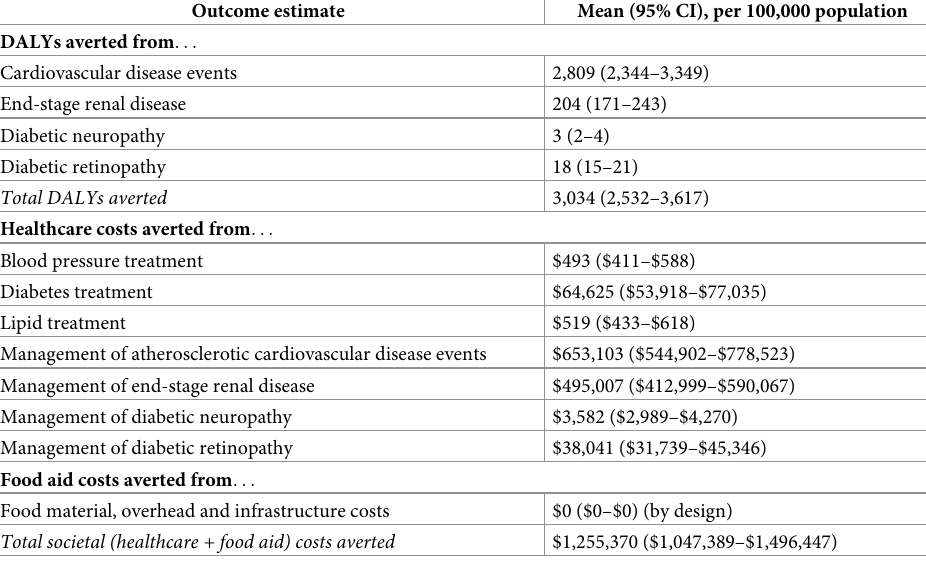
Table 6. Cost-effectiveness analysis. The table shows DALYs and costs (in 2017 US dollars) averted by shifting from traditional food parcel delivery to a food parcel with less grain and increased fruits and vegetables. The parcel has the same total food aid costs, including food material and overhead costs for procurement and delivery. DALYs and costs are discounted at a 3% annual rate and reflect the life-course DALYs averted per 100,000 population from a 10-year policy change. Outcome estimate Mean (95% CI), per 100,000 population DALYs averted from